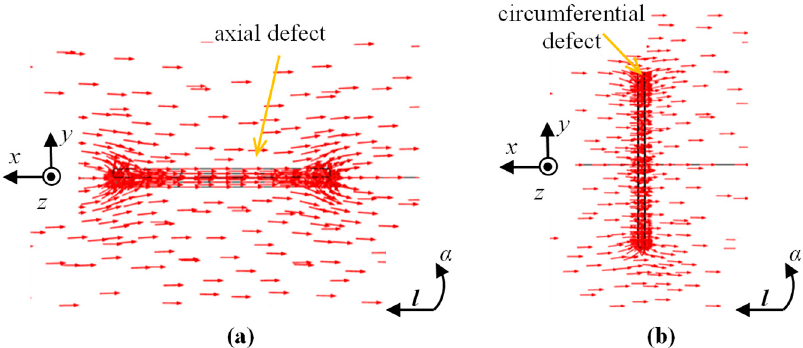
Figure 2. Visualization of magnetic leakage vectors over axial ( a ) and circumferential ( b ) types of defect with depicted scanning circumferential α and axial l directions and sensing x , y , and z directions.